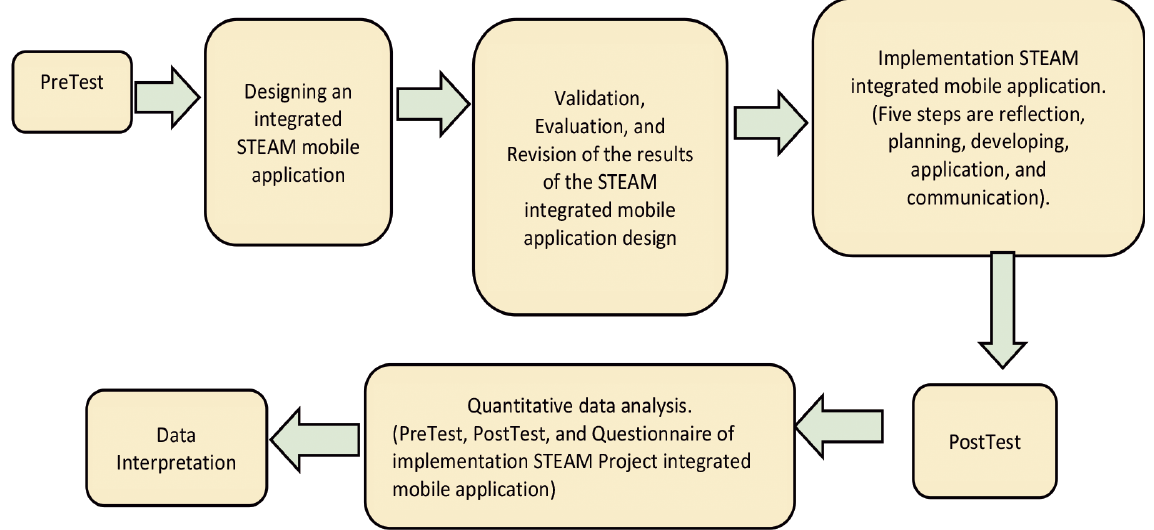
Figure 3. Research Flow and Data Collections Quantitative STEAM integrated mobile application